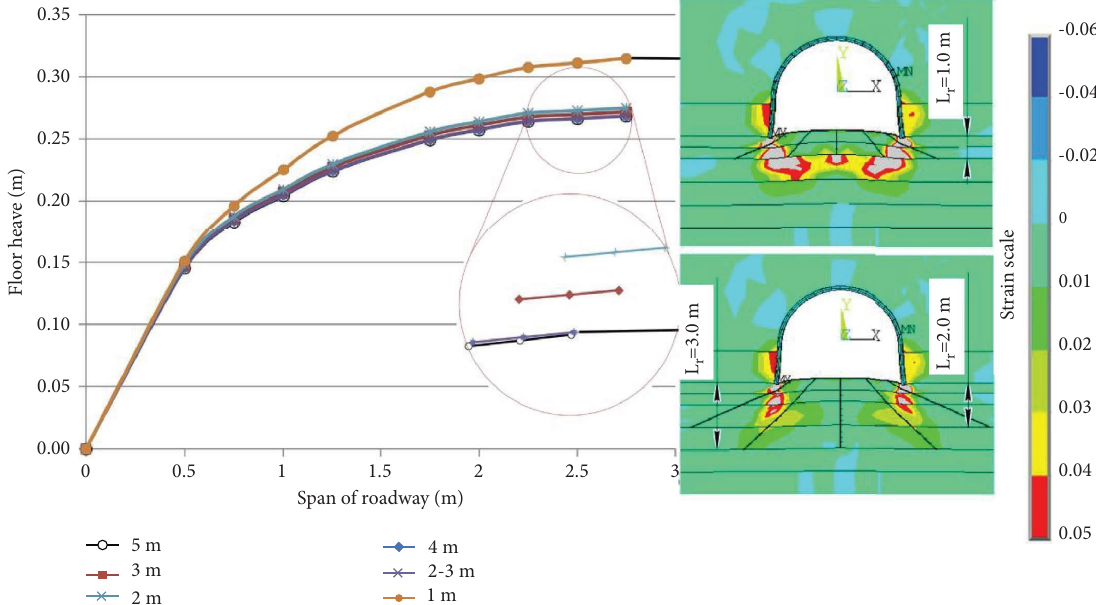
Figure 22: Floor heave on monitoring line B-B 1 (Figure 11) and total maximum principle strain distribution around the roadway after foor supporting with diferent lengths of reinforcement.